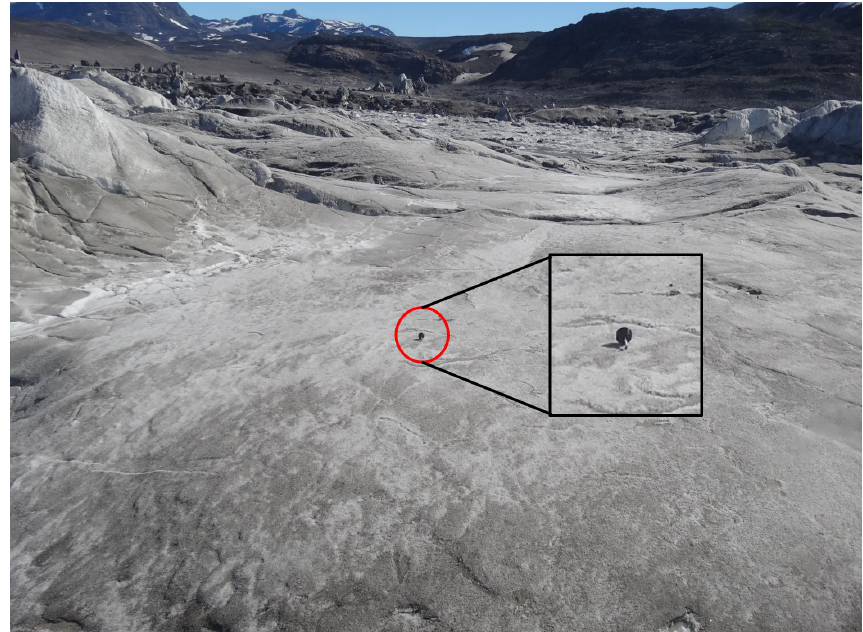
Figure 5. The glacial lake outburst flooding (GLOF) buoy (red circle) deployed on the floating ice in Lake Hullet on 18 June 2019. Inset: an enlargement that shows the buoy resting on the ice after deployment by